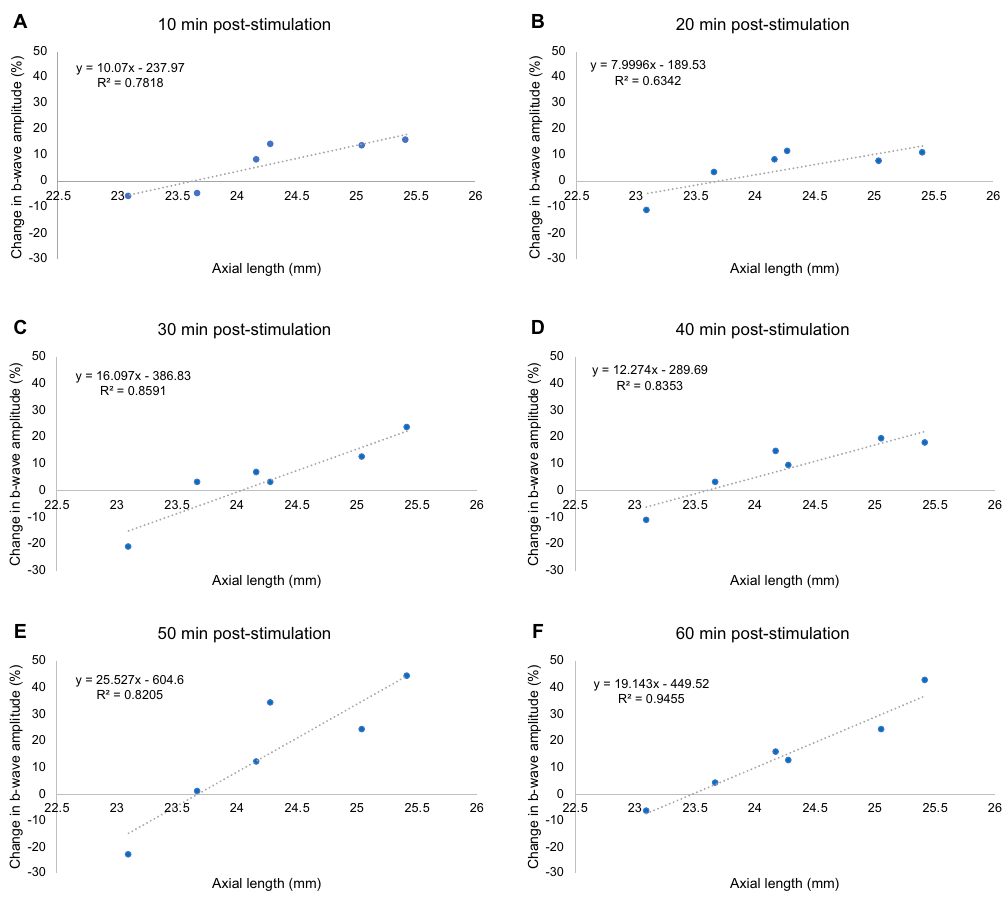
Figure 7. The relationship between axial length (mm) and change in b-wave amplitude (%) relative to baseline are plotted with a trend line for 10 min ( A ), 20 min ( B ), 30 min ( C ), 40 min ( D ), 50 min ( E ), and 60 min ( F ) after the 10 min stimulation